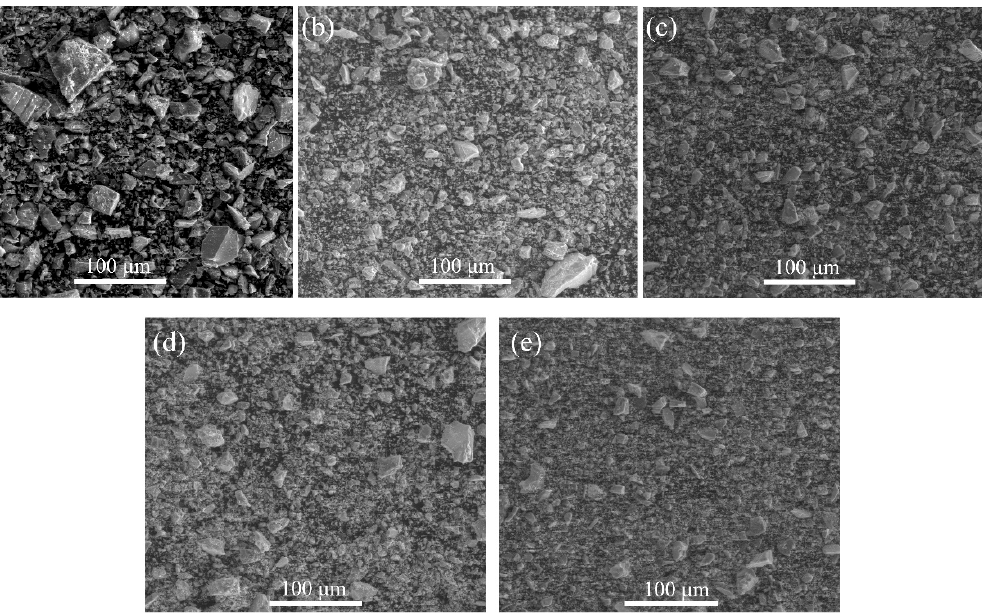
Figure 1. Morphology of copper slag powder. ( a ) 0 min, ( b ) 30 min, ( c ) 60 min, ( d ) 90 min, and ( e ) 120 min.